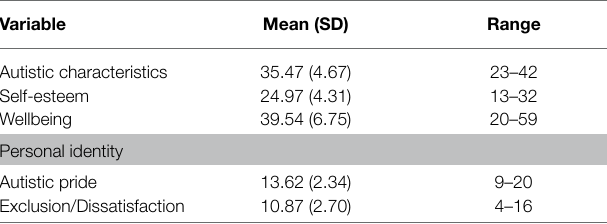
TABLE 2 | Means and SDs for autistic characteristics, self-esteem, wellbeing, and personal identity subscales. Variable